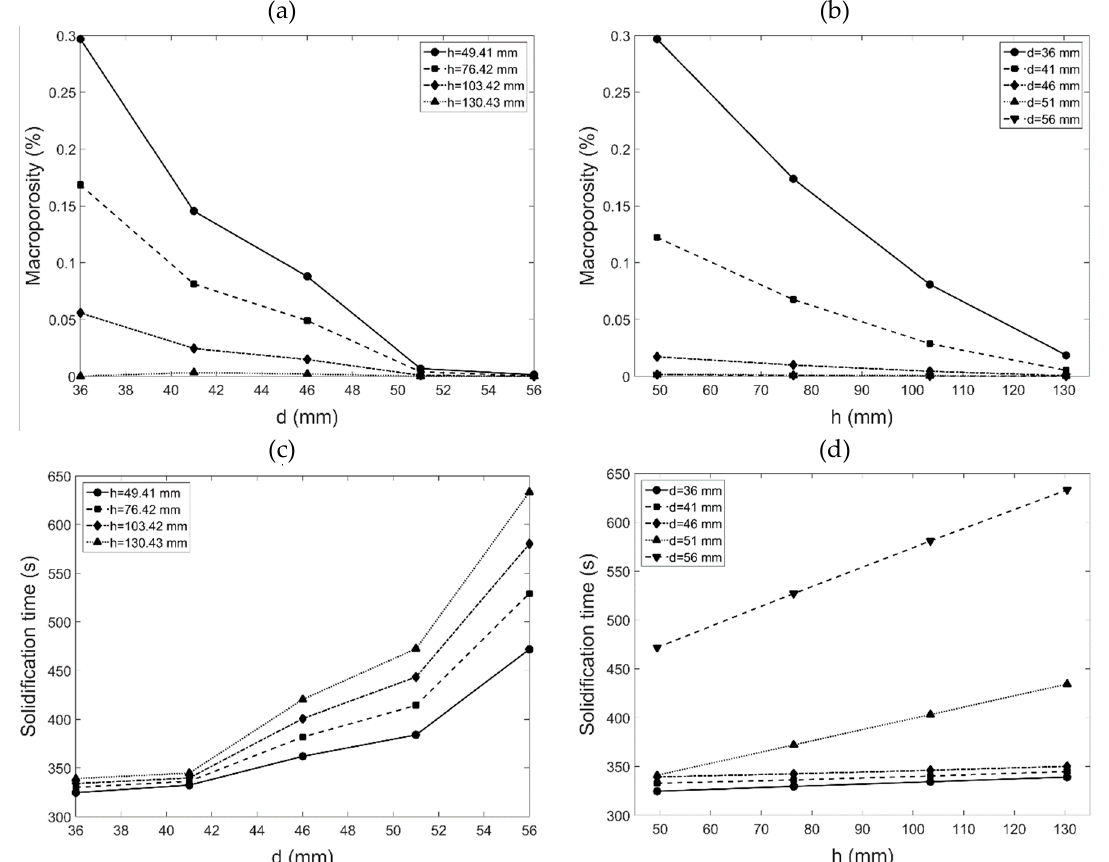
Figure 4. Percentage porosity plotted as a function of the ( a ) riser diameter and ( b ) riser height. Solidification time plotted as a function of the ( c ) riser diameter and ( d ) riser height.